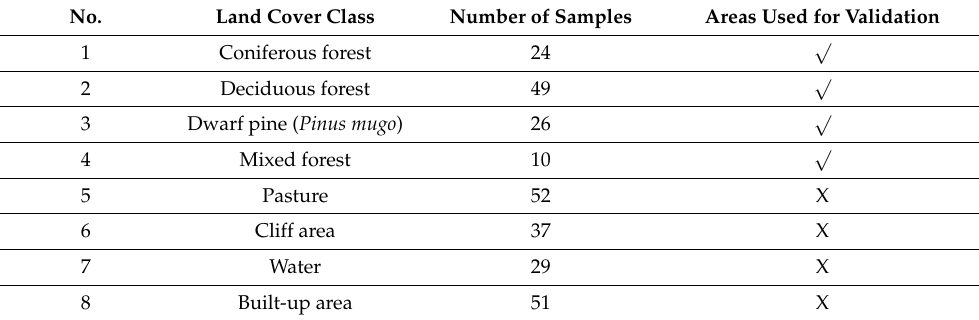
Table 2. Land cover classes and number of samples used for supervised classification on Sentinel-2 MSI